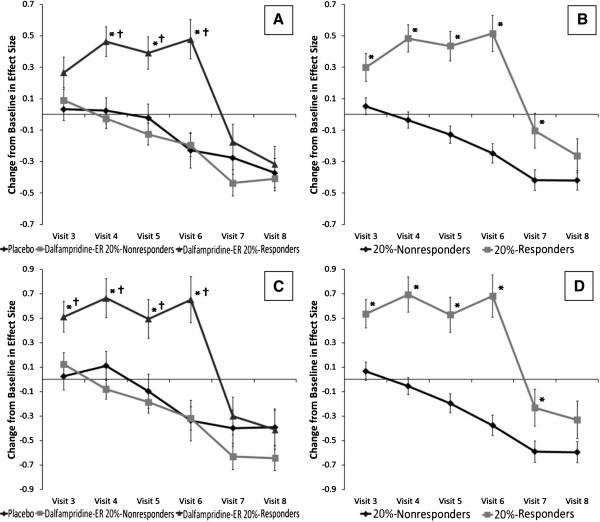
Effect sizes of change in EQ-5D by responder status and treatment group. Change in effect size for EQ-5D when stratified by treatment group (dalfampridine-ER 20%-responder status or placebo) and 20%-responder status (≥20% percent increase in Timed 25-Foot Walk speed or < 20%) during on-treatment visits 3-6 and off treatment visits 7/8. A, B) results using North American-derived equation; C, D) results using United Kingdom-derived equation. *p < 0.05 versus D-ER nonresponders; †p < 0.05 versus placebo.